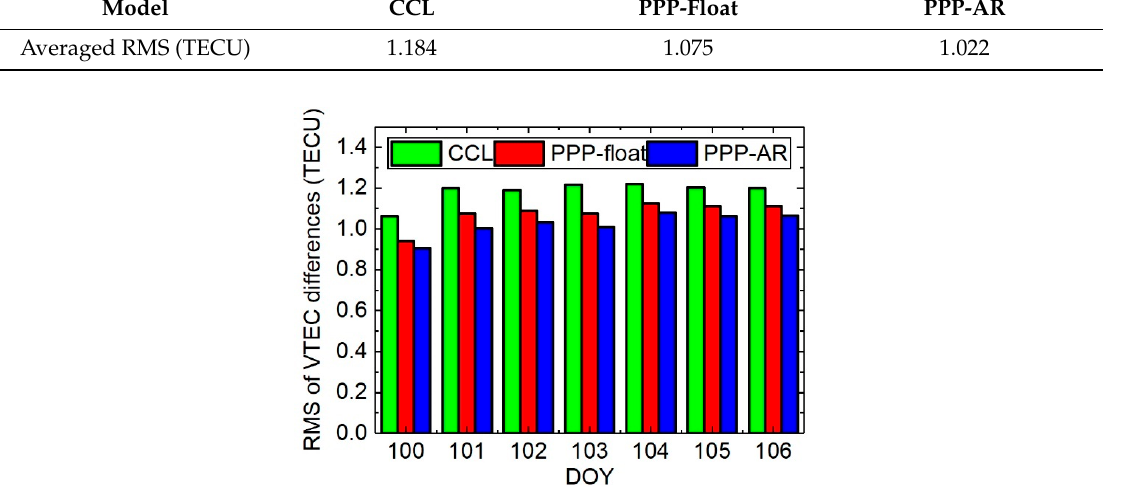
Figure 12. Averaged biases of satellite DCBs for three methods compared to CODE final monthly products from DOY 100 to 106, 2017. Table 7. Averaged RMS of satellite DCBs compared with CODE final monthly satellite DCB products for DOY 100 to 106, 2017. Model CCL